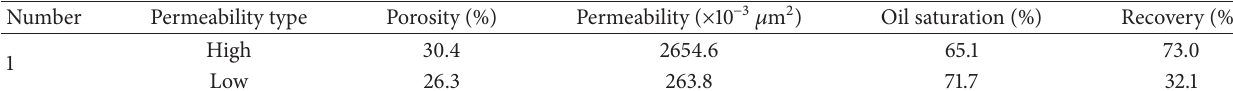
Table 2: Sand pack parameters.